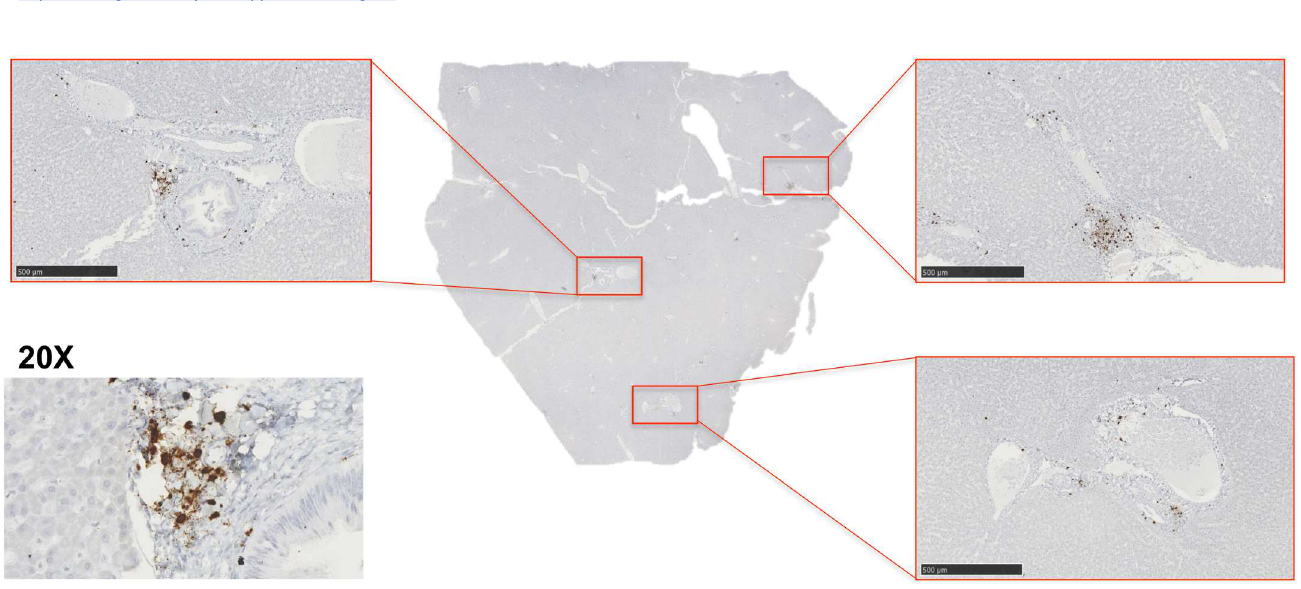
Fig 7. SIV-infected cells localize around the portal triads. A) RNAscope in situ hybridization was used to detect SIV RNA-positive cells in the liver. Images were captured from whole tissue scans at 5x magnification (images outlined in red, scale bar = 500 um) and depict SIV-infected cells around the portal triads. A representative 20x image of a portal triad was included of the SIV-RNA positive cells (brown cells).